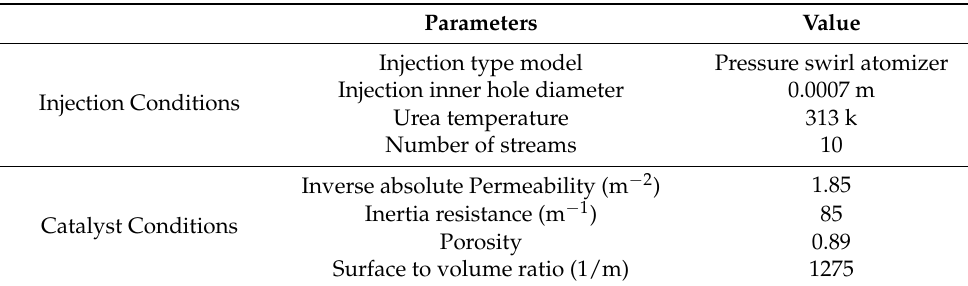
Table 2. Injection system and catalyst